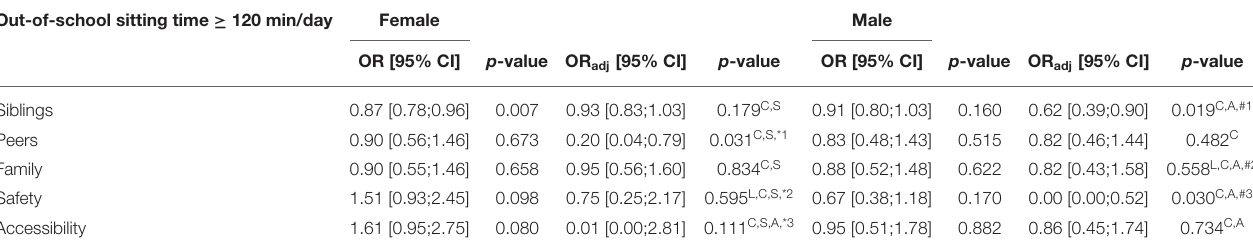
TABLE 2 | Associations between out-of-school sitting time and socioenvironmental factors one by one adjusted with the confounding factors (place of living, ethnic community, age) and interactions. Out-of-school sitting time ≥ 120 min/day